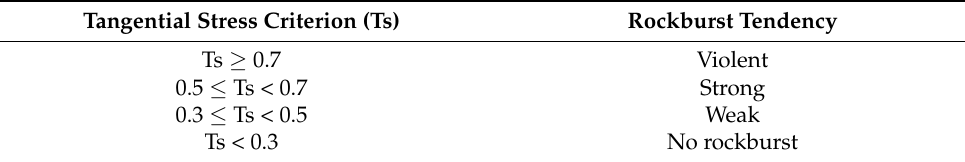
Table 5. Rockburst tendency prediction based on tangential stress